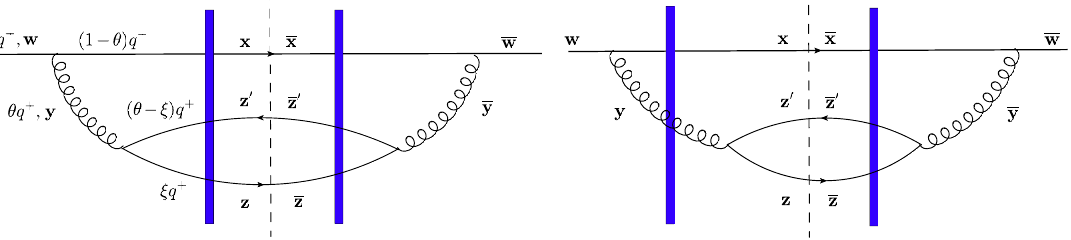
Figure 8 . Left: the graph corresponding to final-state interactions in both the DA and the CCA; its colour structure is encoded in the 6-quark S -matrix shown in eq. (3.33). Right: a graph describing interference between interactions in the intermediate state in the DA and respectively in the